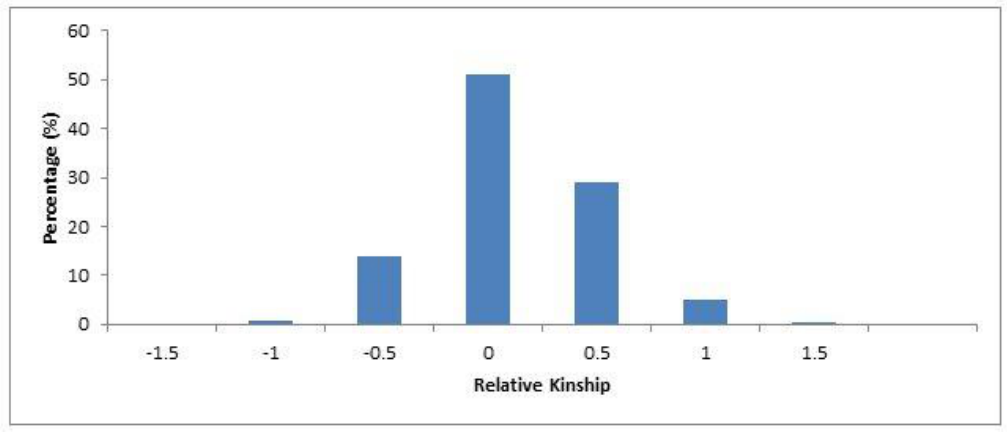
Figure 4. The proportion of pairwise kinship coefficients in international safflower panel. Table 4. Analysis of molecular variance among countries and within country groups of safflower germplasm.